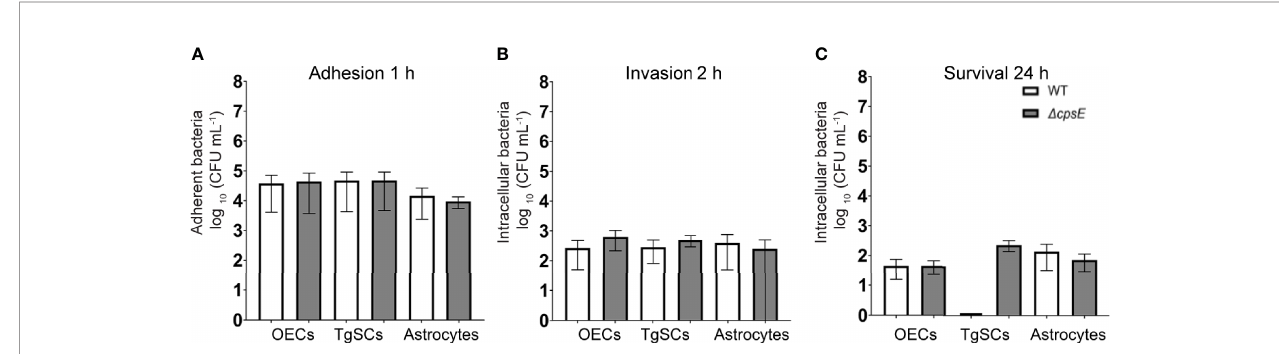
FIGURE 3 | Comparison of adhesion/invasion of glia by S. agalactiae . (A) Cell monolayers were inoculated with WT or D cpsE bacteria for 1 h (MOI 100), followed by colony counts to determine the number of adherent bacteria. (B, C) After 1 h, penicillin, streptomycin and gentamicin were added to the medium to kill extracellular bacteria, and at 2 h (B) or 24 h (C) cells were lysed to recover intracellular bacteria and colony counts were performed. Data shows mean ± SEM of three independent experiments with n = 3 technical replicates. Data were compared between glial types using two-way ANOVA with Tukey ’ s multiple comparison test; no signi fi cant differences were detected. CFU/mL values of zero were assigned a value of 1 to enable display on log10 axes (in graph (C) , TgSCs WT value is